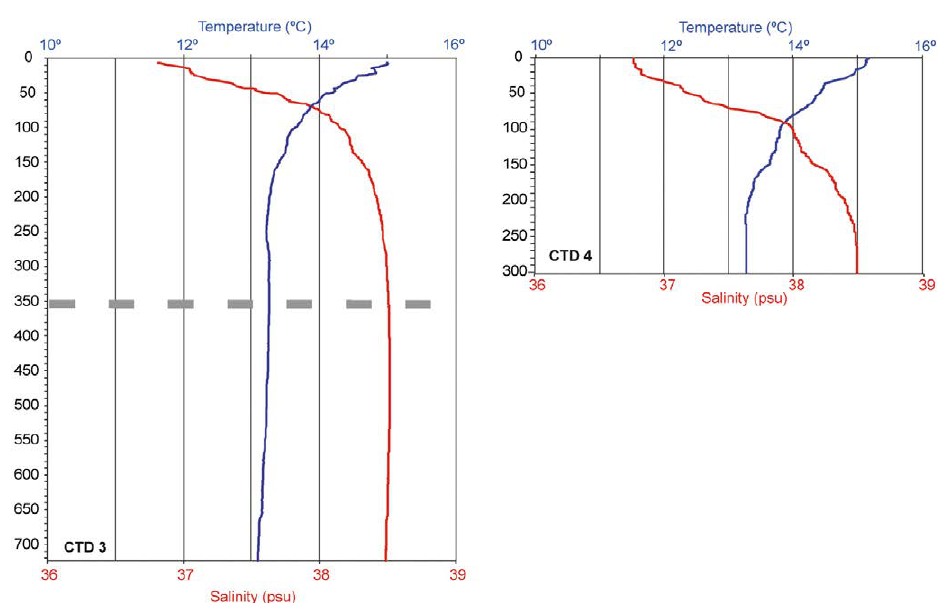
Fig. 2. – Conductivity-temperature-depth (CTD) profiles obtained over Algarrobo Bank and nearby (see Fig. 1). The dashed line on CTD 3 indicates the approximate depth of haul BT04 made at the adjacent Algarrobo Bank, over which the CTD 4 was taken. Superficial layers with salinity less than 37.5 psu are influenced by the inflow of Atlantic origin. Below ca. 250 m depth, the water temperature stabilizes slightly over 13°C and salinity near 38.5 psu, values indicating the westward flowing Levantine Intermediate Water.